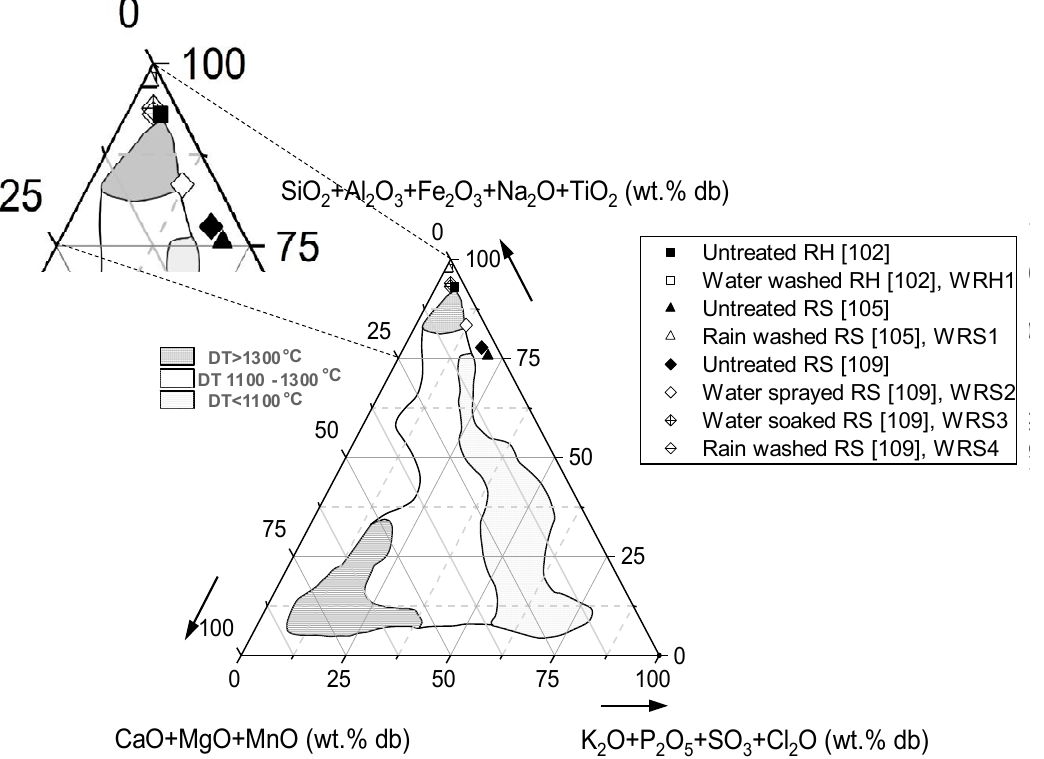
Figure 4. The effect of fuel washing strategies on the melting tendency of RH and RS (data were taken from